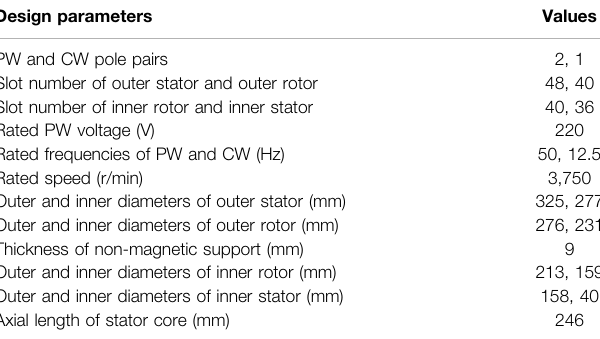
TABLE 1 | Speci fi cation of proposed DS-BDFIM-SDCR Design parameters Values